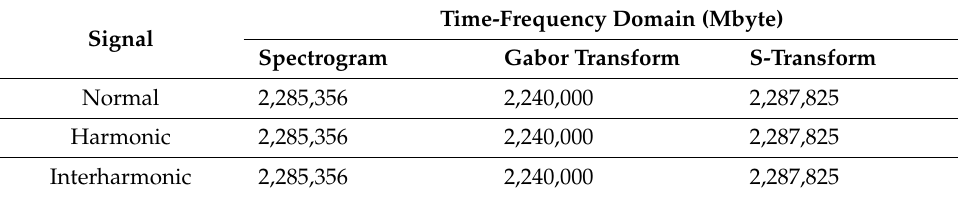
Table 4. The MAPE of the memory size of data